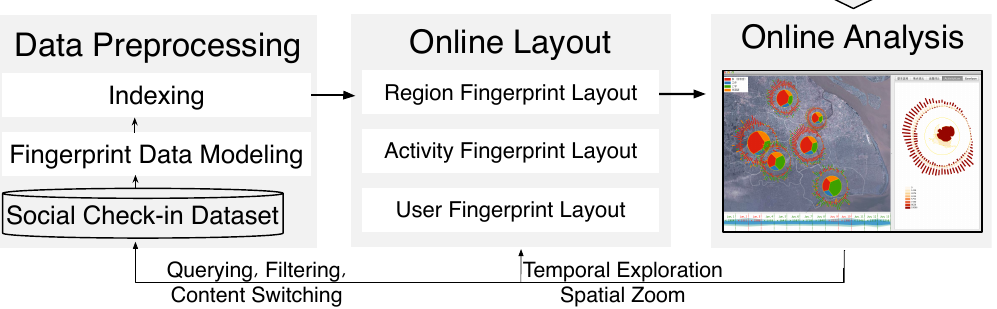
Figure 4. System overview and data processing pipeline. The Sci-Fin system consists of three primary components: (1) a data transformation module; (2) an online layout and rendering module; and (3) a user online analysis and interaction